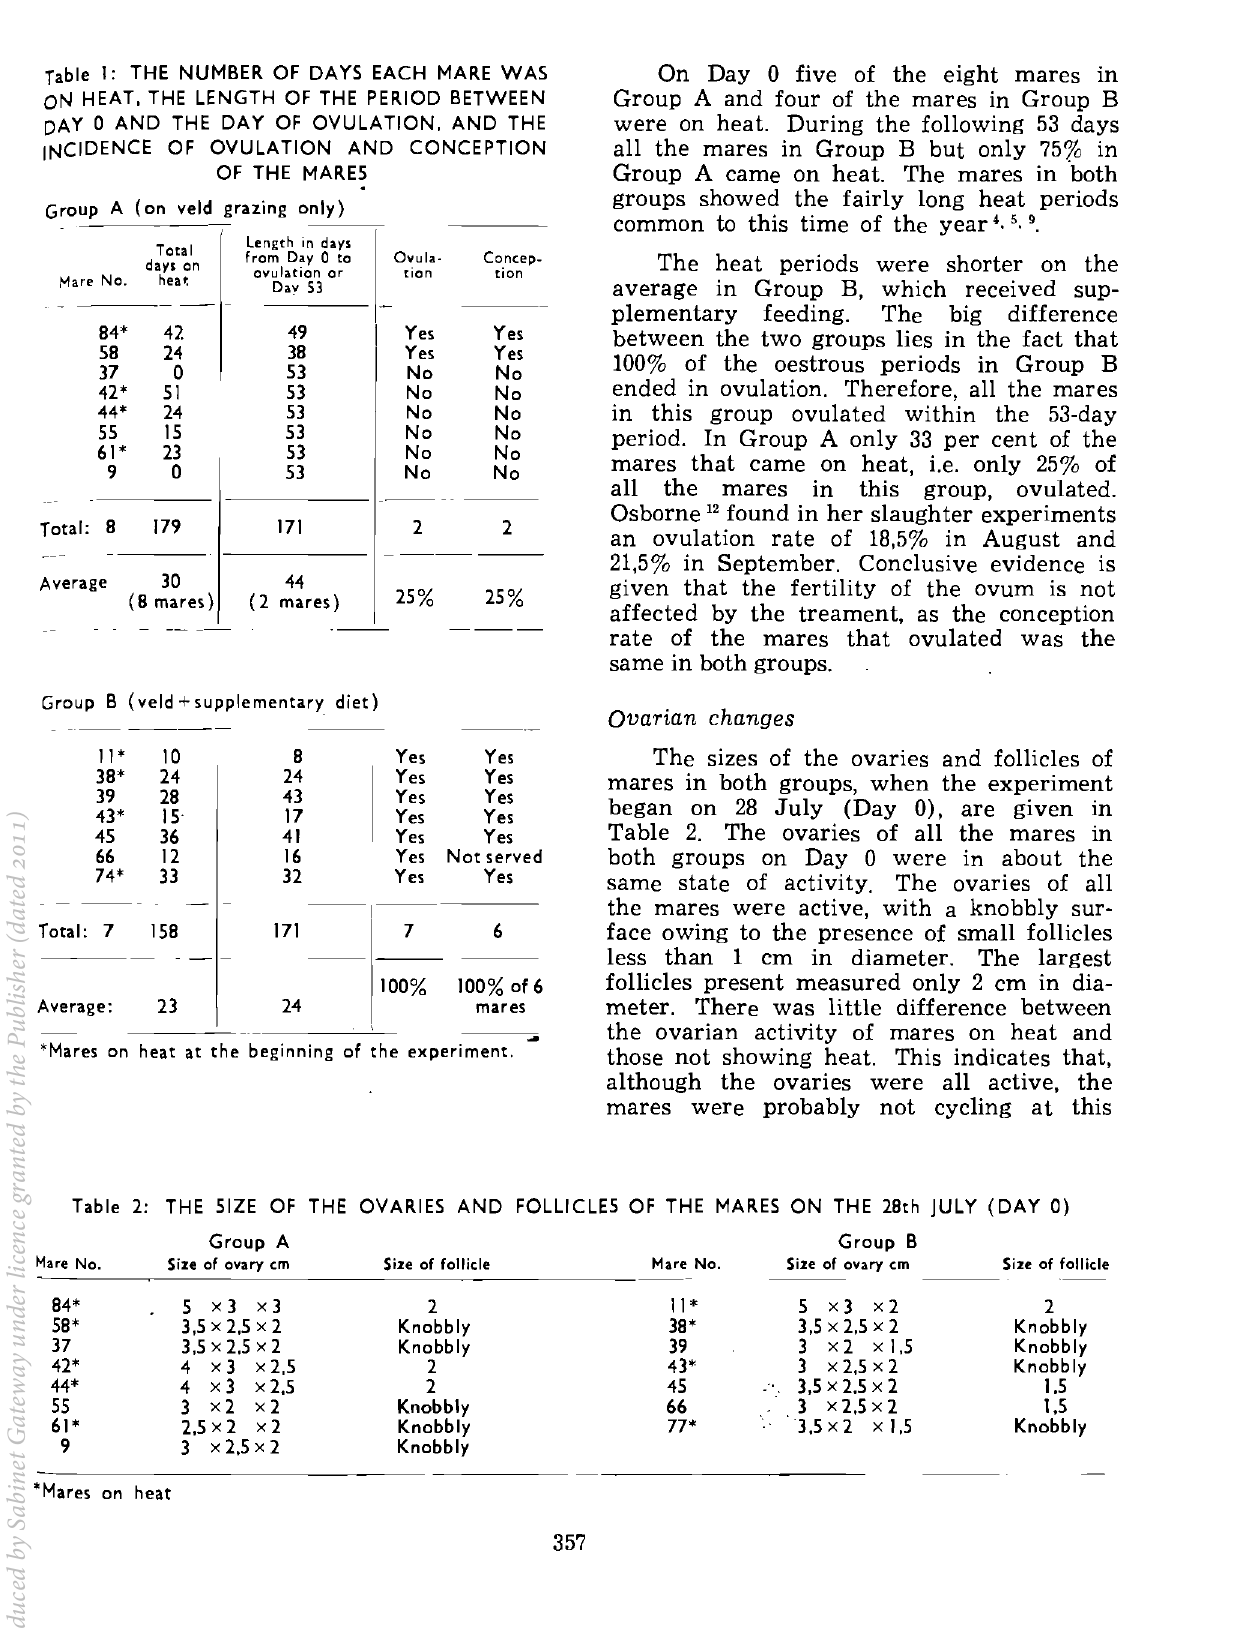
On Day 0 five of the eight mares in Table I: THE NUMBER OF DAYS EACH MARE WAS Group A and four of the mares in Group B ON HEAT. THE LENGTH OF THE PERIOD BETWEEN were on heat. During the following 53 days DAY 0 AND THE DAY OF OVULATION. AND THE all the mares in Group B but only 75% in INCIDENCE OF OVULATION AND CONCEPTION Group A came on heat. The mares in both OF THE MARES groups showed the fairly long heat periods GroUp A (on veld grazing only) common to this time of the year 4, 5. 9.